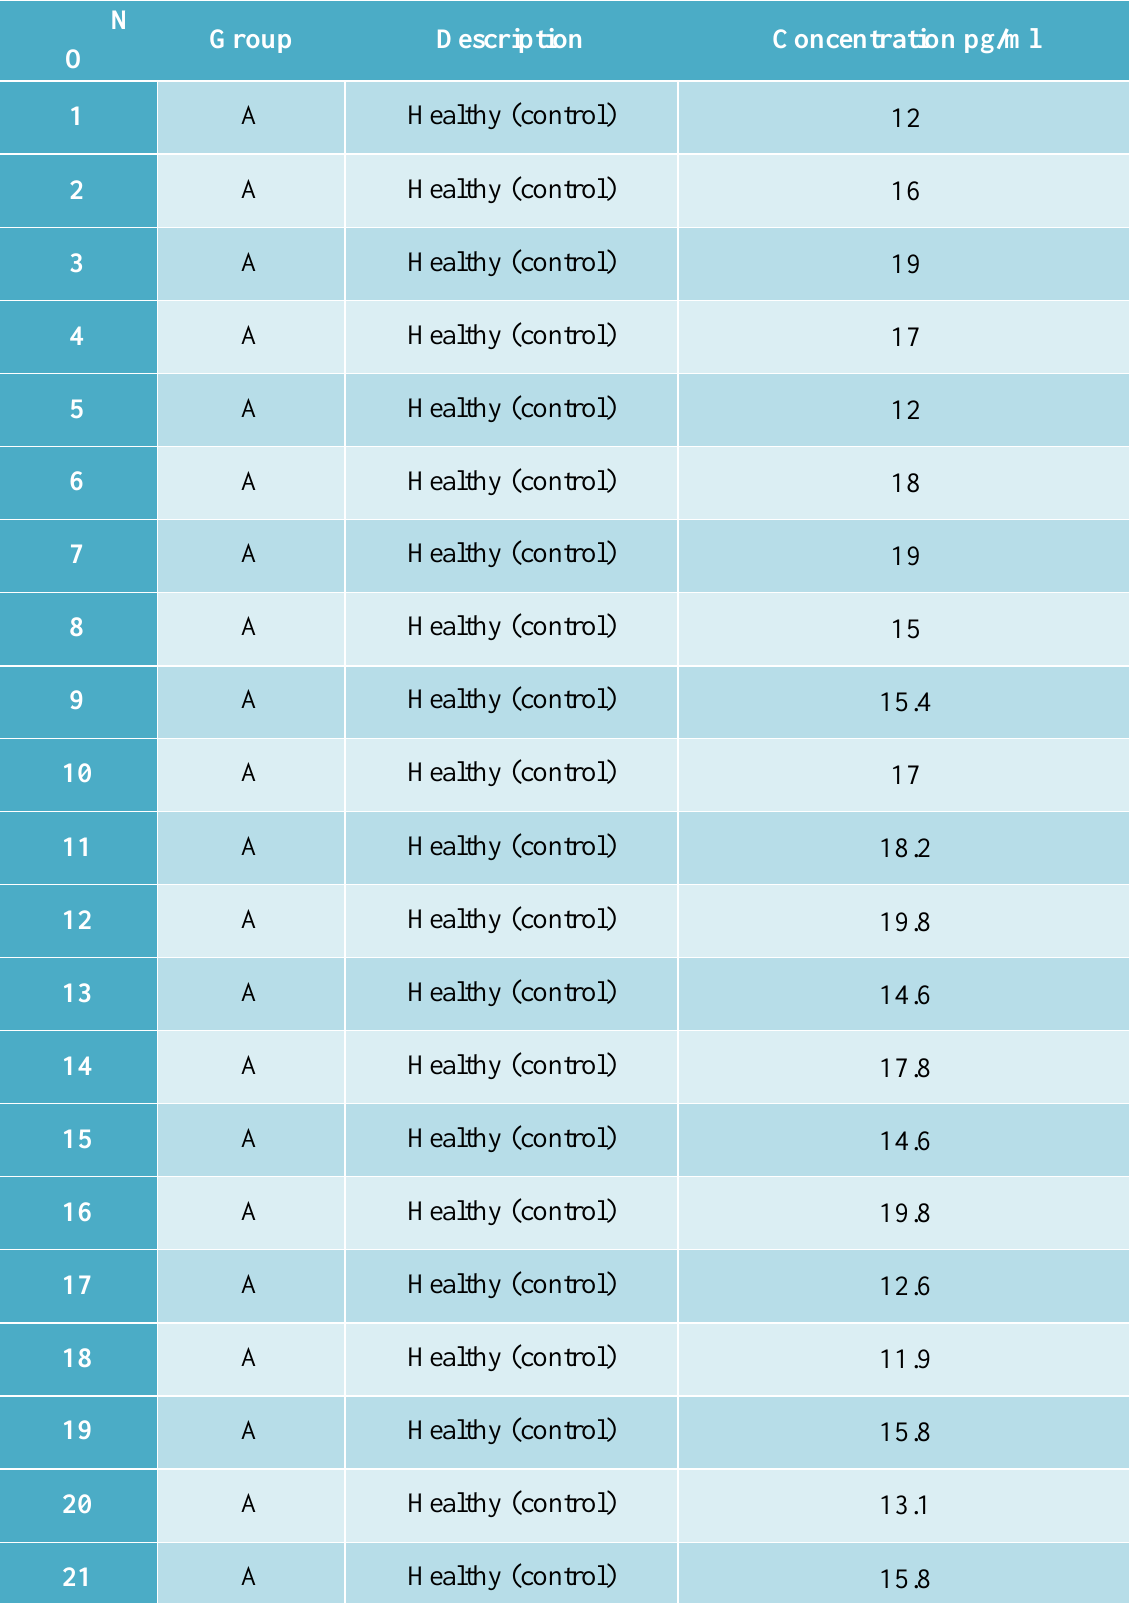
Table 2: The results of the Concentration of Interferon gamma (IFNγ) in serum of healthy subjects